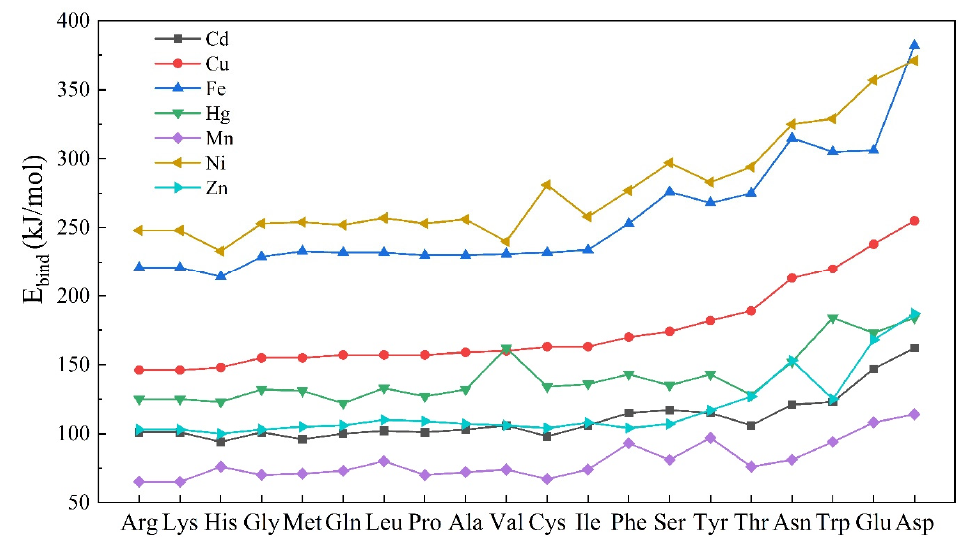
Figure 3. The comparison of the most stable complex binding energies during 20 AAs and seven kinds of metal cation interactions.